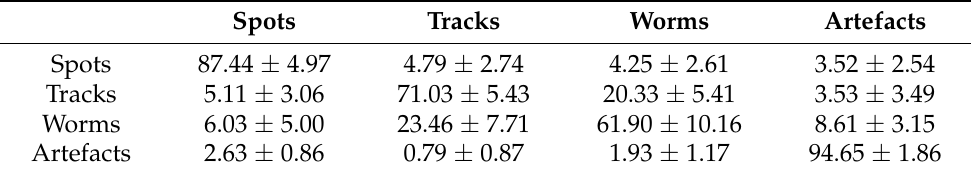
Table 7. Confusion matrix of the network with the input convolutional DenseNet201 architecture. Spots Tracks Worms